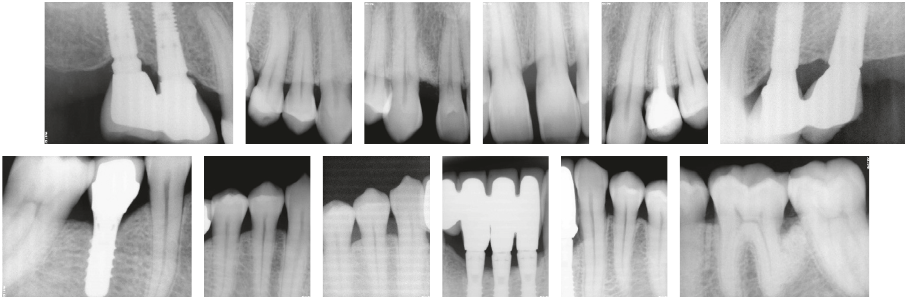
Figure 7: Radiographic evaluation 10 years after prosthesis insertion.